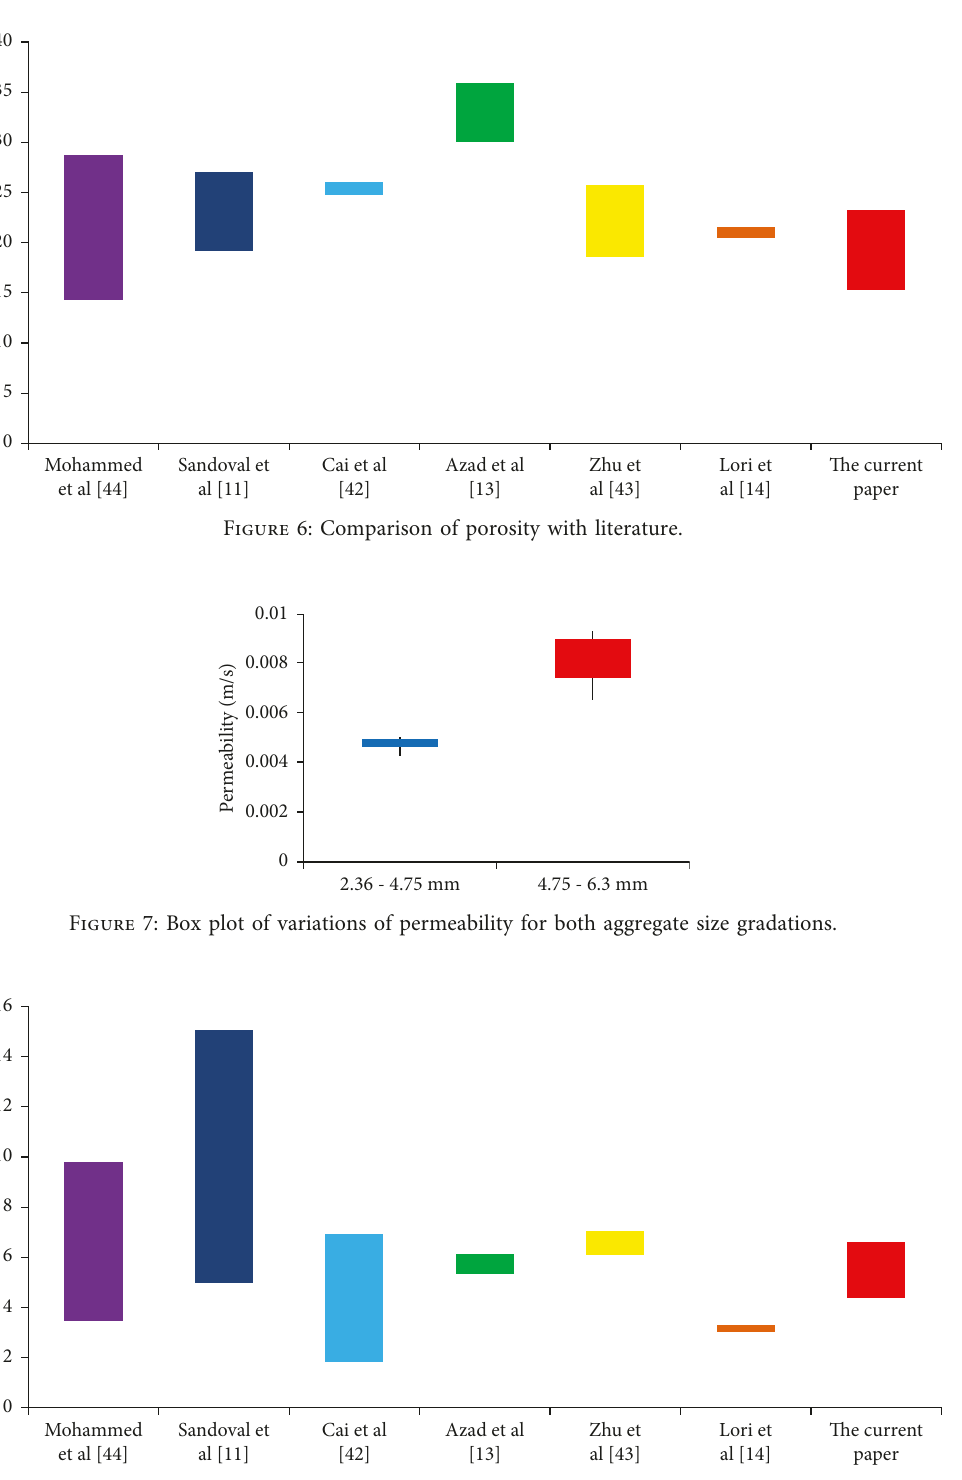
Figure 8: Comparison of permeability with